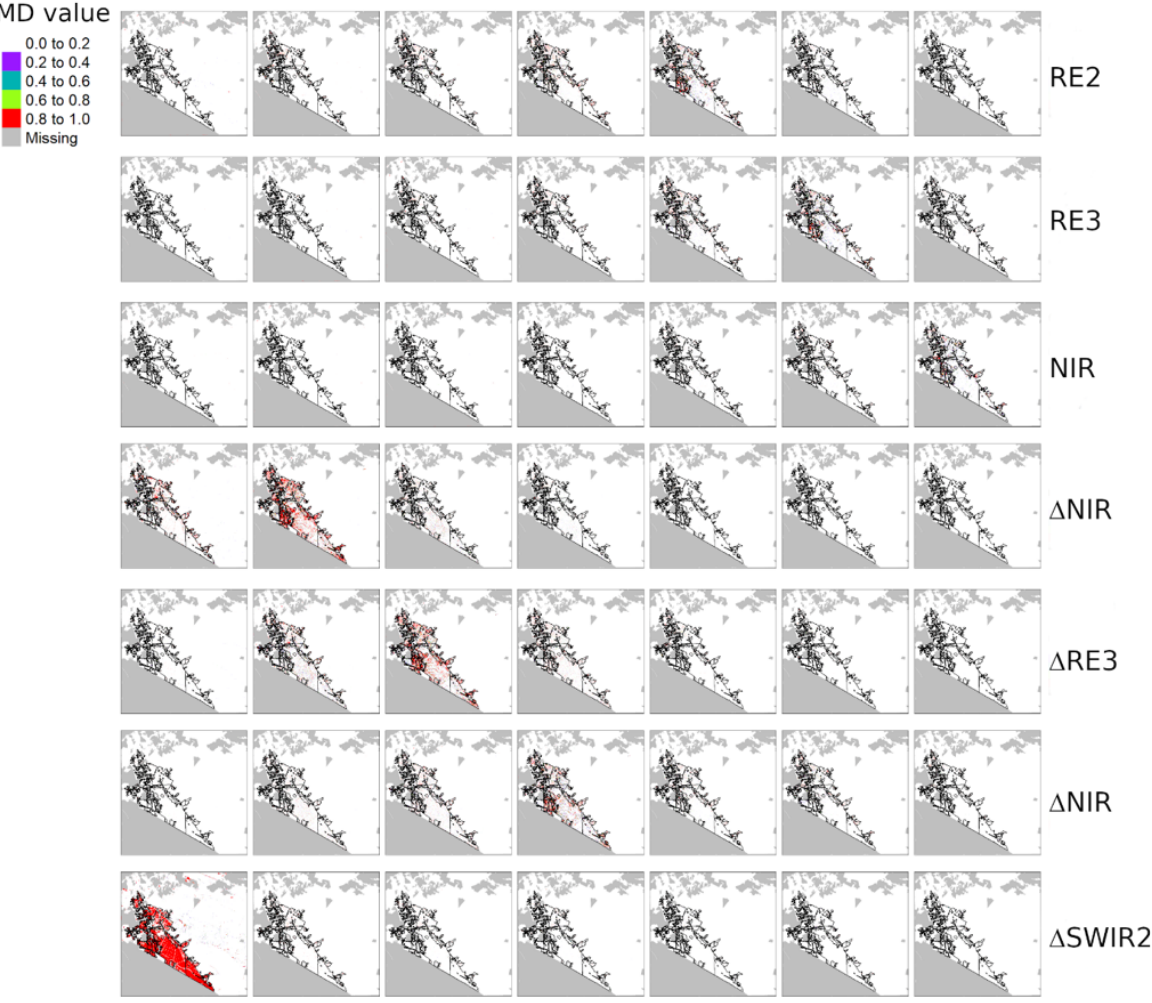
Figure 7. Contribution of each feature MD after the re-ordering step ( g i , i = 1, . . . 7) over the Huelva site, Spain: panels are ordered from left to right to show pixels contributing to the i-th position. Along the columns, each pixel value belongs to the n-th features and contributes to the i-th ordered